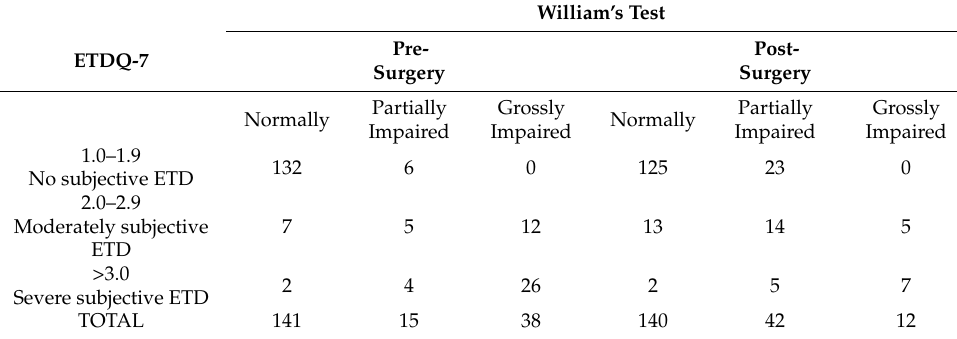
Table 3. ETDQ-7 score and William’s test assessment before and after